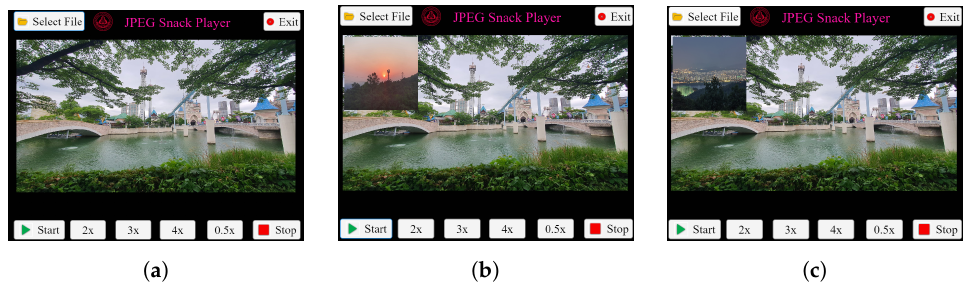
Figure 9. JPEG Snack Player playing JPEG Snack file with a sequence of images. ( a ) When the JPEG Snack file is selected, the JPEG-1 image is displayed. ( b ) After 2 s, the first image from the sequence is displayed. ( c ) After 3 s, the second image from the sequence is